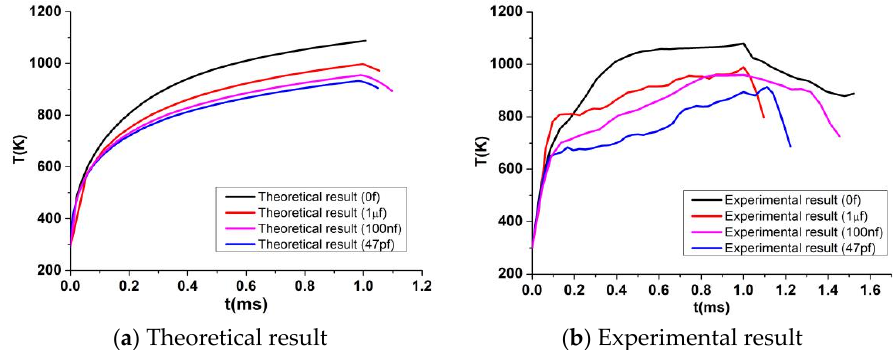
Figure 2. The theoretical and experimental temperature rise characteristics of Si ‐ APD (pulse width 1.0 ms and energy density 15 J/cm 2 ). 1.0 ms and energy density 15 J/cm 2